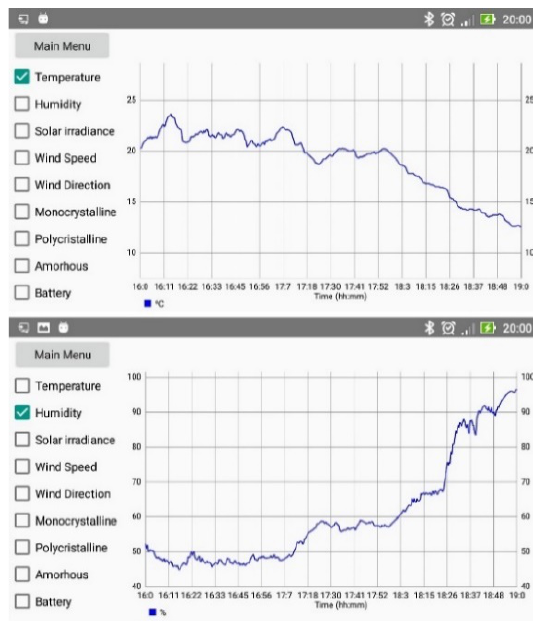
Figure 14. Graphs of the temperature and humidity measured by the weather station along the time provided by the developed mobile app.